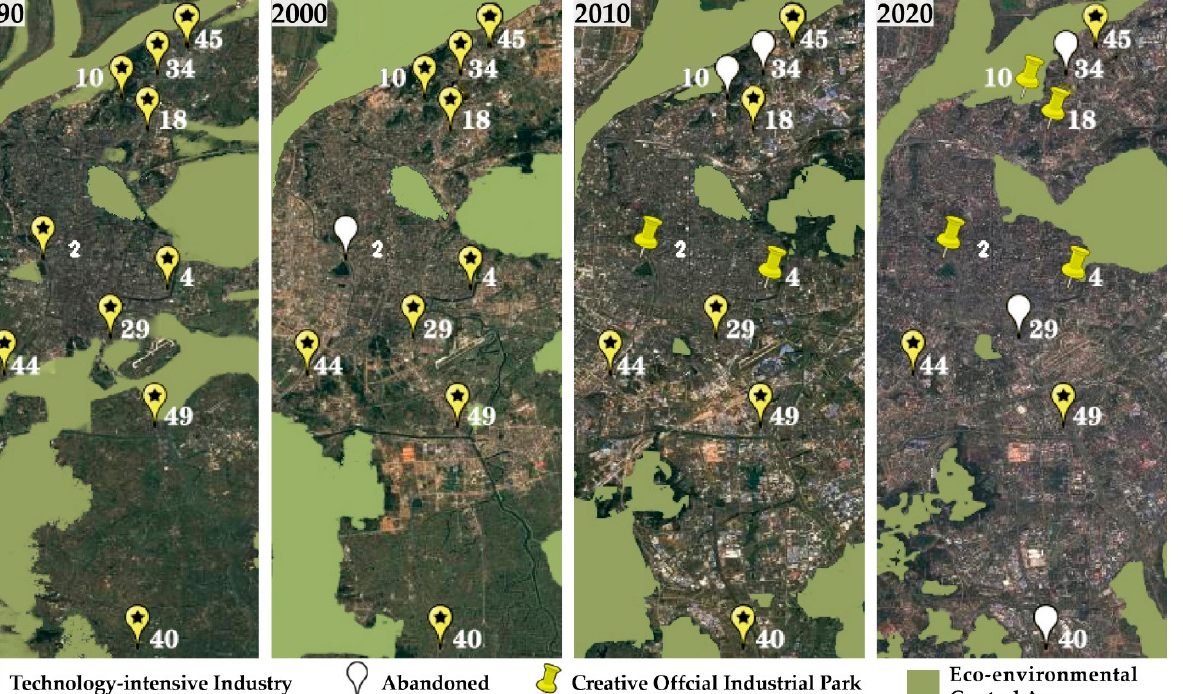
Table 3. Statistics of accessibility analysis of technology-intensive industrial heritage.